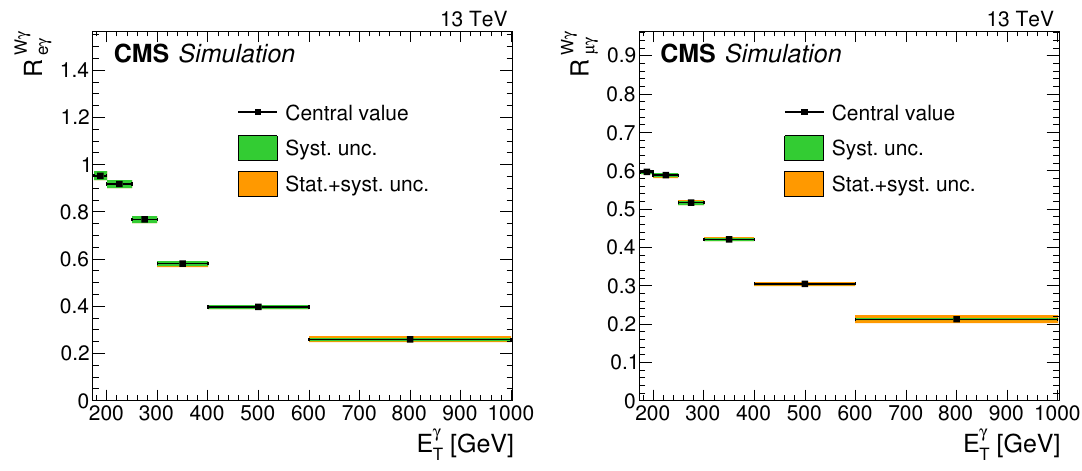
Figure 3 . Transfer factors R W (cid:13) (left) and R W (cid:13) (right). The uncertainty bands in green (inner) and e (cid:13) (cid:22)(cid:13) orange (outer) show the systematic uncertainty, and the combination of systematic and statistical uncertainty arising from limited MC sample size, respectively. The systematic uncertainties consid- ered are the uncertainties in the data-to-simulation correction factors (cid:26) for the lepton identi(cid:12)cation